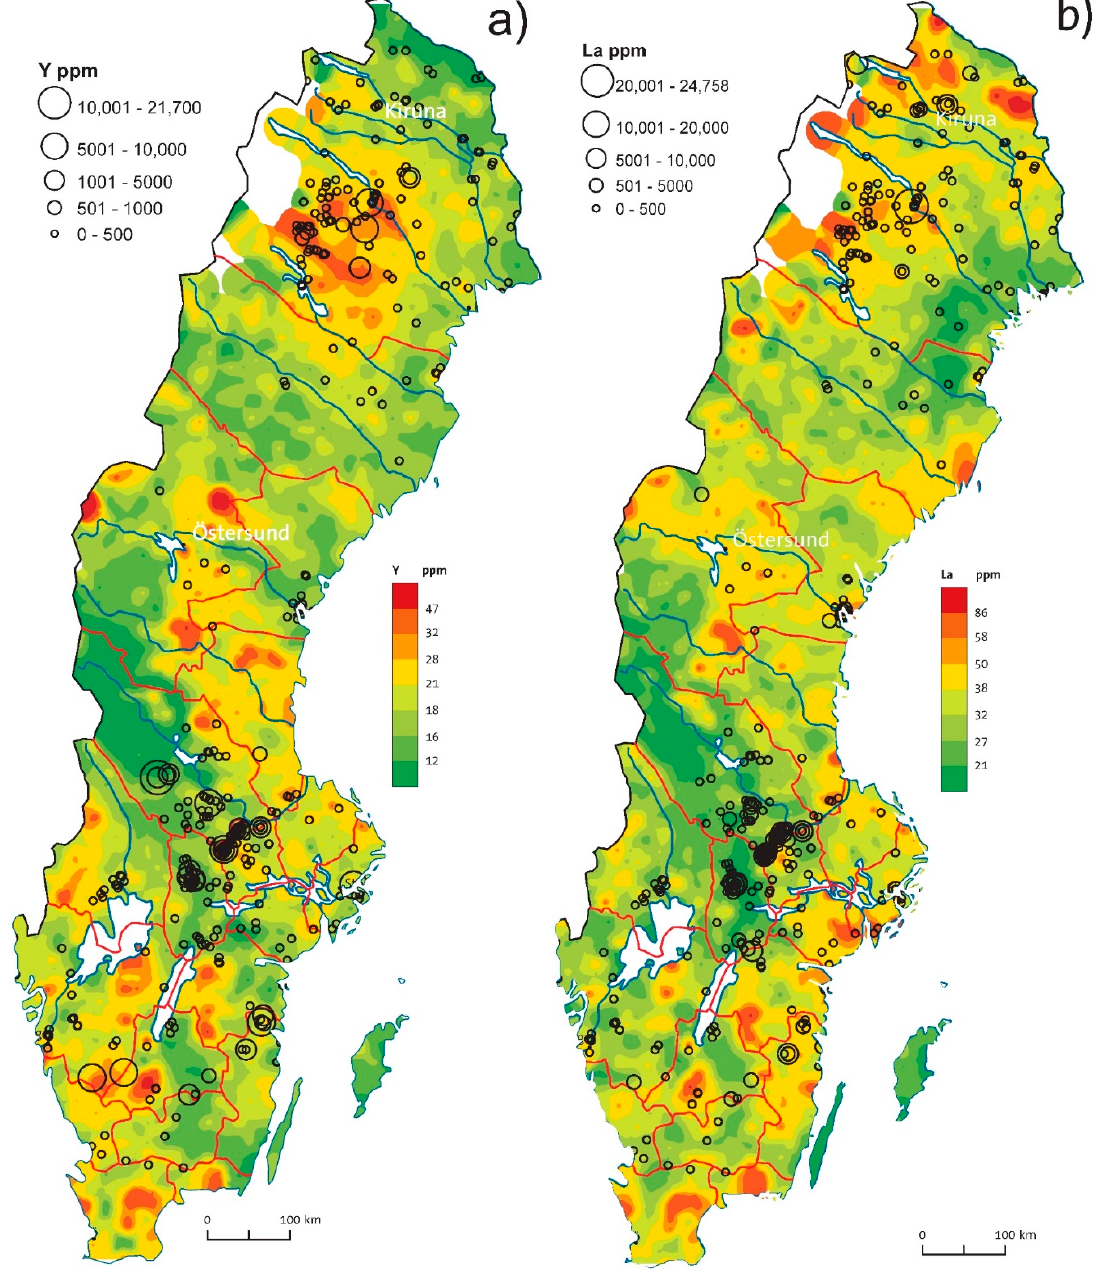
Figure 11. Geochemical maps comparing till geochemistry (raster, after Andersson et al., 2014 [3]) with lithogeochemistry (circle symbols) in Sweden: ( a ) La in till and bedrock; ( b ) Y in till and bedrock. LREEs and Eu have major anomalies in northernmost Sweden (outlying Archean lithologies of magmatic origin) while these anomalies are absent in HREEs. Minor enrichment in LREEs visible